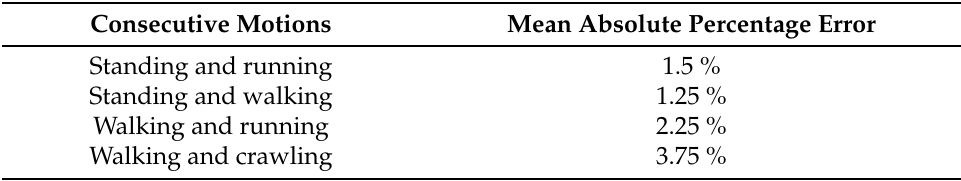
Table 1. Mean absolute percentage error for the estimation of the boundary